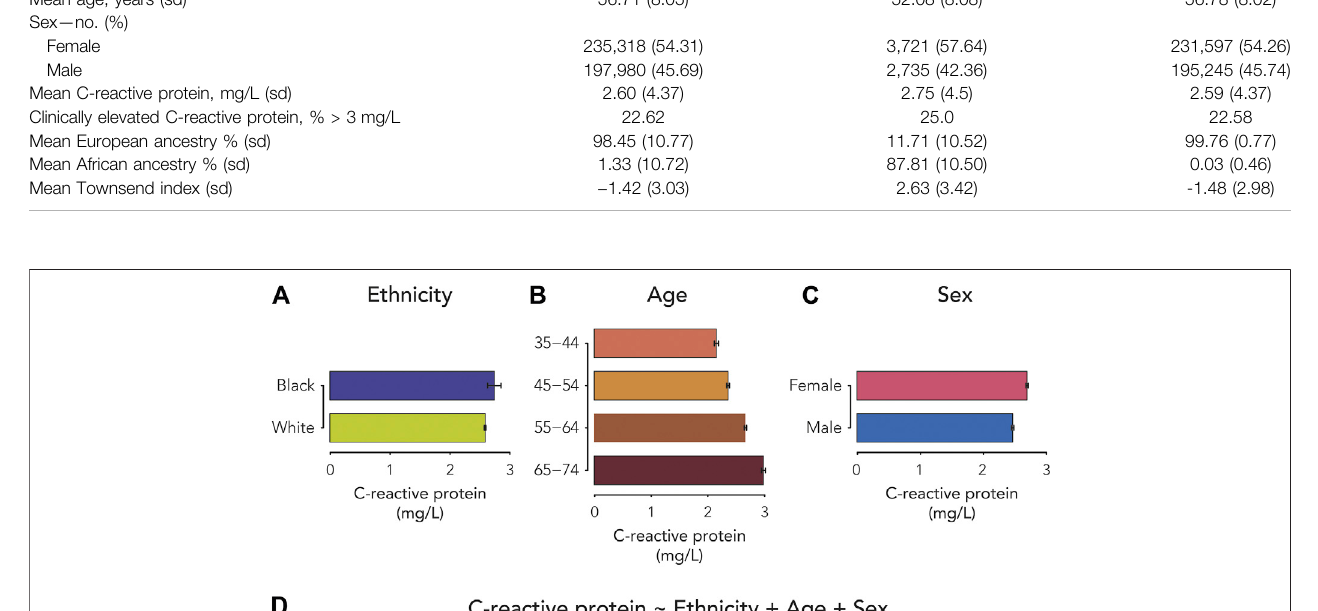
CRP for Black male participants compared to White male participants ( Figure 2 ).